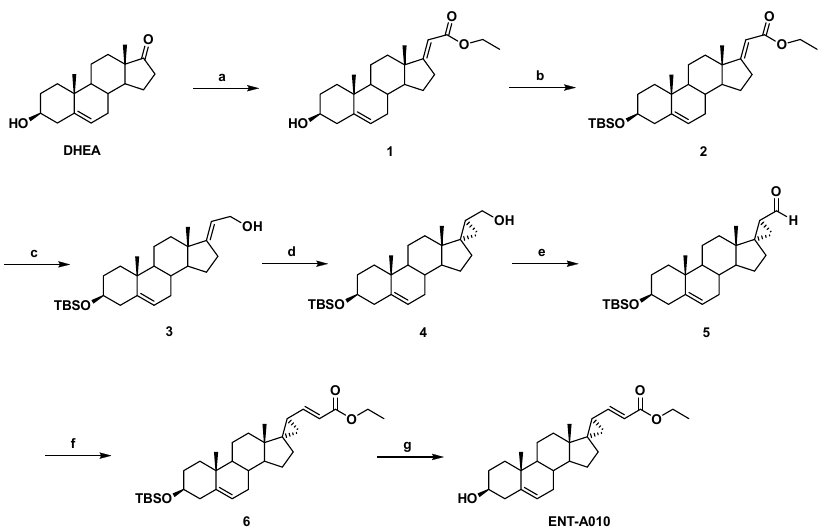
Figure 1. Synthesis of ENT-A010. Reagents and conditions: ( a ) (CH 3 CH 2 O) 2 P(O)CH 2 C(O)OCH 2 CH 3 , EtONa, THF/EtOH 1:1, reflux, overnight; ( b ) TBSCl, Imidazole, I 2, THF, 0 ◦ C to 25 ◦ C, overnight; ( c ) DIBAL-H, CH 2 Cl 2 , − 78 ◦ C, 2.5 h; ( d ) CH 2 I 2 , Et 2 Zn, − 78 ◦ C to 25 ◦ C, 1 h; ( e ) Dess-Martin periodinane, DCM, 0 ◦ C to 25 ◦ C, 1.5 h; ( f ) (CH 3 CH 2 O) 2 P(O)CH 2 C(O)OCH 2 CH 3 , NaH, THF, 0 ◦ C to 25 ◦ C, 0.5 h; ( g ) TBAF (1.0 M in THF), THF, 0 ◦ C to 25 ◦ C, overnight.